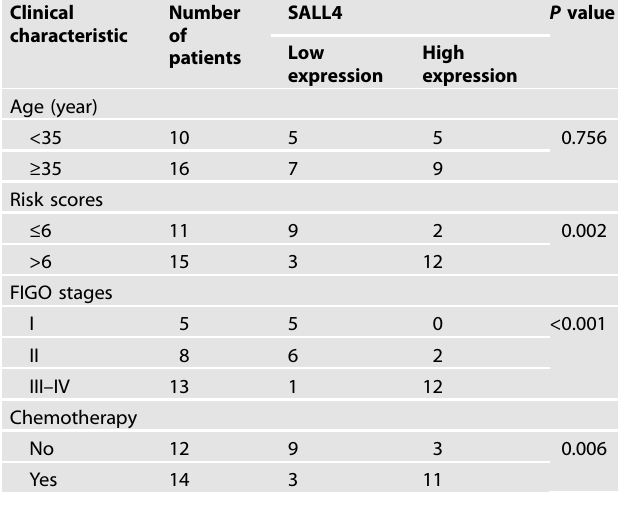
Table 1. SALL4 expression and clinicopathological features in 26 choriocarcinoma patients.